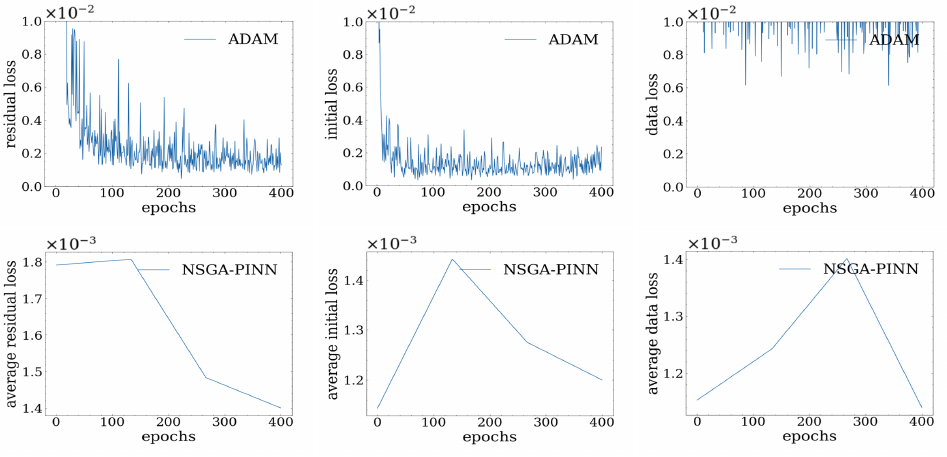
Figure 5. Inverse pendulum problem with data noise: Group of figures from left to right columns show each loss value by using different training method with noisy